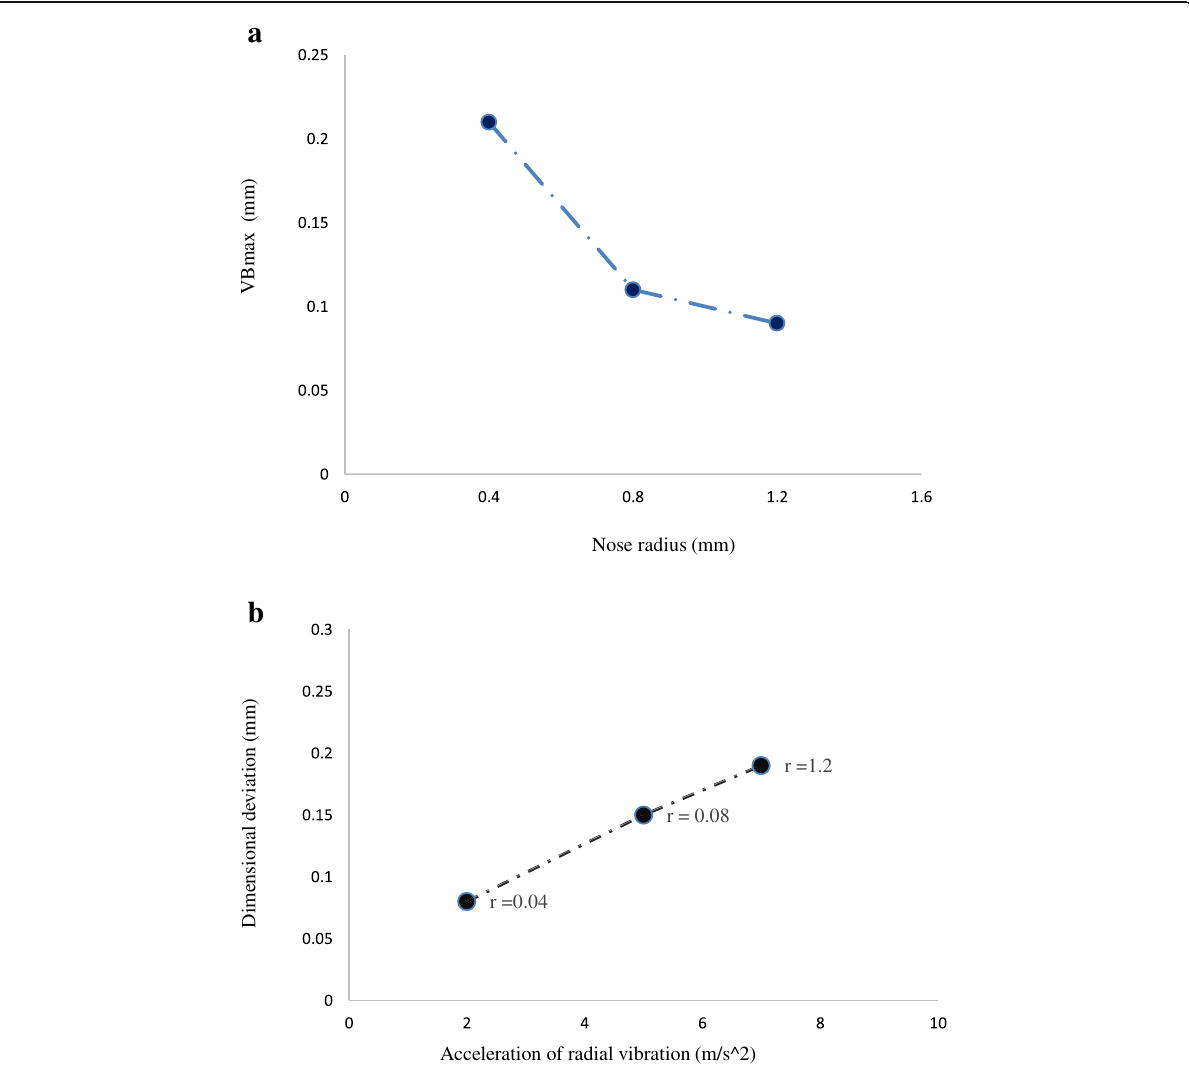
Fig. 2 a The nose radius effect on the maximum flank wear. b The effect of the nose radius on the vibration at 0.08 mm/rev feed rate, 0.5 mm cutting depth, and 1000-rpm